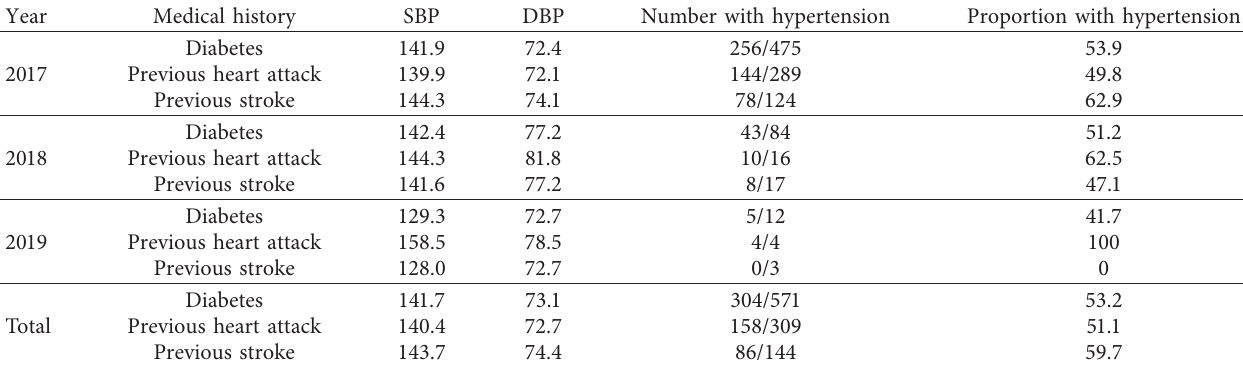
Table 3: Mean BP of participants according to medical